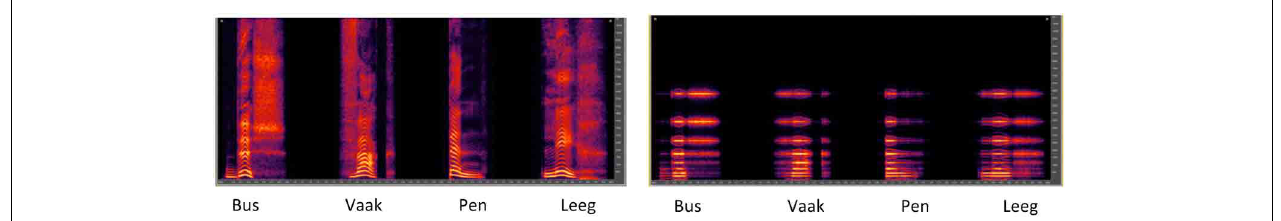
FIGURE 1 | Spectrograms for Dutch monosyllabic words “Bus,” “Vaak,” “Pen,” and “Leeg” (“Bus,” “Often,” “Pen,” and “Empty” in English), shown for unprocessed speech (left panel) or with the CI simulation (right panel).